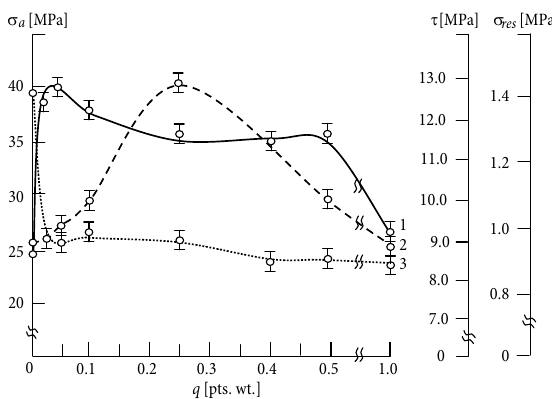
q [pts. wt.] Fig. 1. Dependence of adhesive strength and residual stresses of the epoxy matrix on the filler content MMSCO: curve 1 – adhesive strength in isolation σ а ; curve 2 – adhesive strength in shear τ ; curve 3 – residual stresses σ res